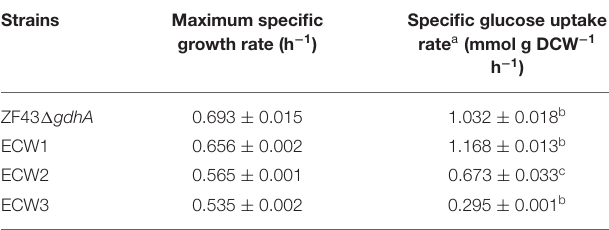
TABLE 1 | Maximum specific growth rates and average specific glucose uptake rates of Escherichia coli strains ZF43 1 gdhA , ECW1, ECW2, and ECW3.